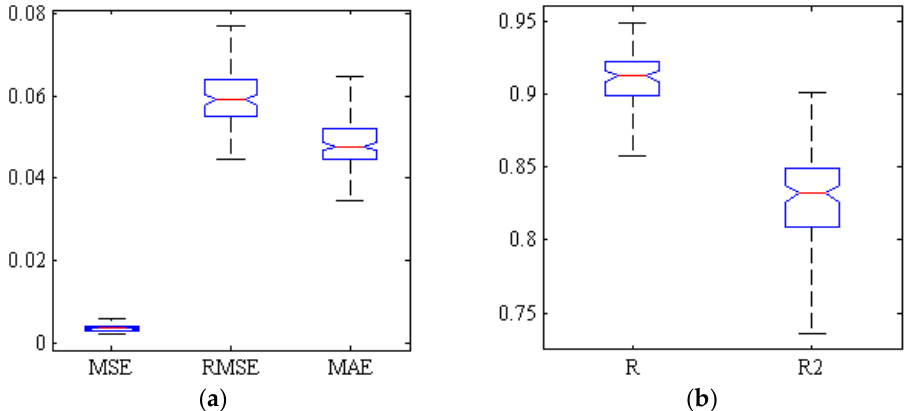
Figure 3. Box of five criteria for evaluating the performance of ANN-PSO algorithm for estimating the TA of Gala cultivar based on spectral data of key wavelengths. ( a ) Error criteria, ( b ) Correlation coefficients and determination.